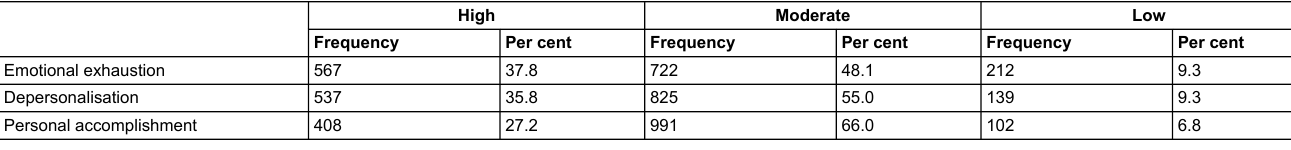
Table 3: Number and percentage of participants reporting high, moderate, and low levels of the respective burnout dimensions (n =